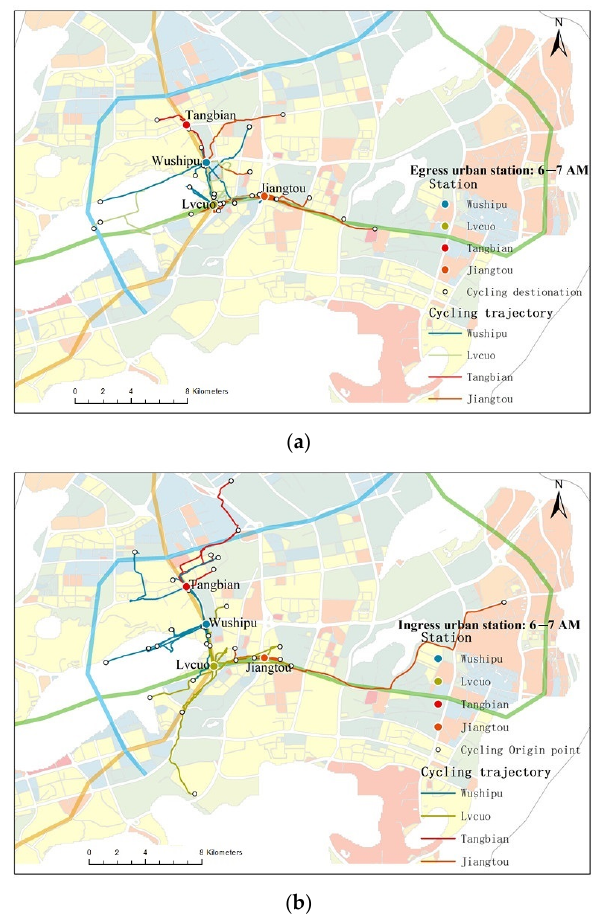
Figure 8. ( a ) Cycling trajectory for egress metro station between 6:00 and 7:00 a.m. ( b ) Cycling trajectory for ingress metro station between 6:00 and 7:00 a.m. Figure 8a,b depicts the transitory exit and entrance situation at an urban rail station.